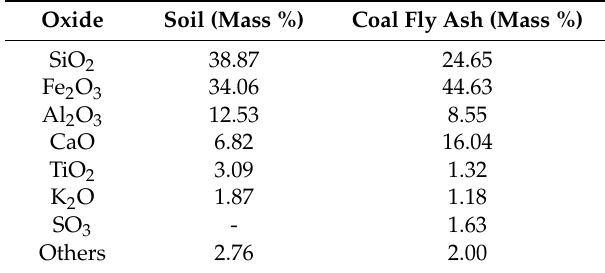
Table 2. Chemical composition of soil and fly ash.